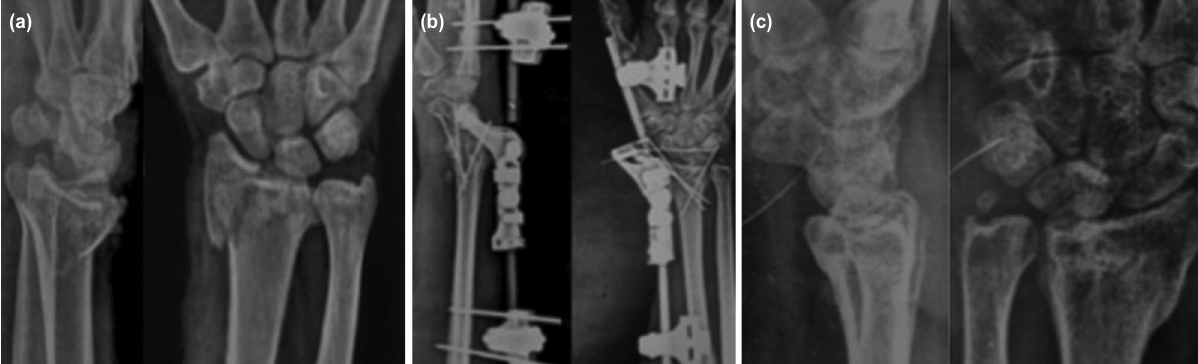
Radiographs of right wrist (a) pre-operative, (b) post-operative, (c) after 12 Fig. 2: